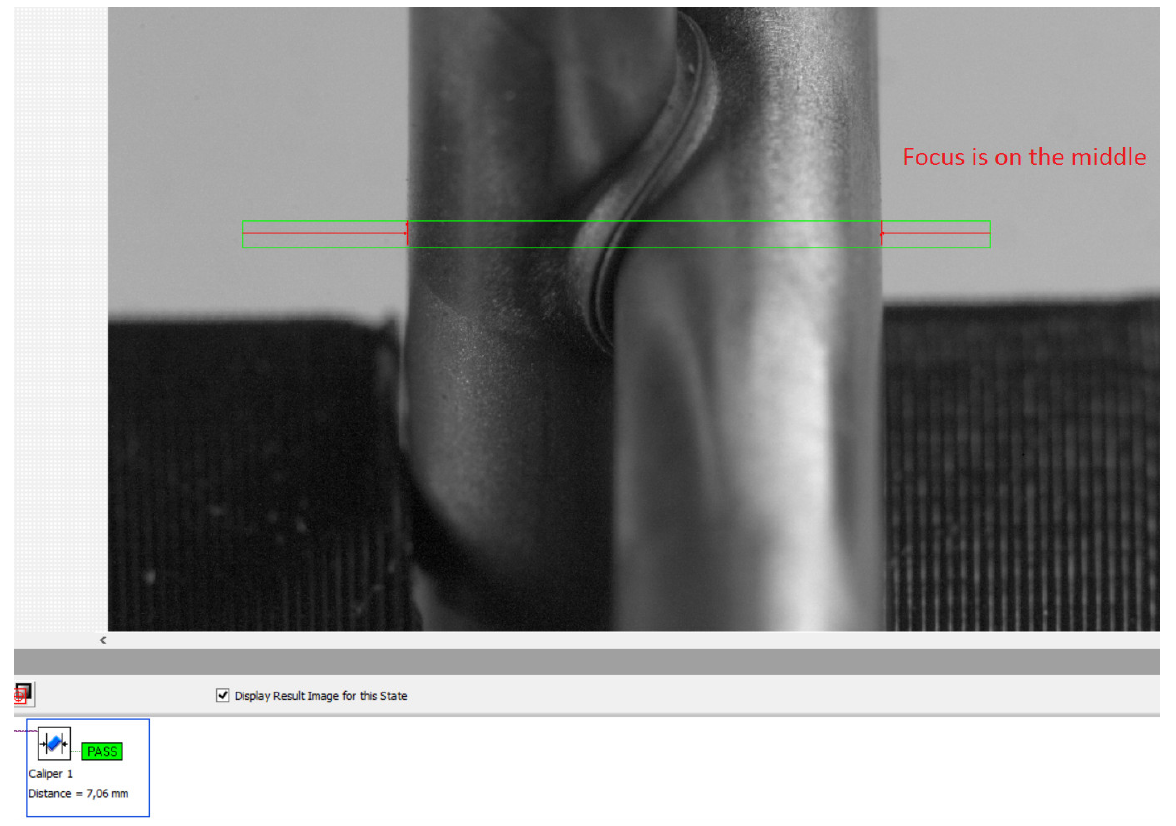
Figure 9. Measuring dimension in NiVison program with a focus in the middle of wire crossing. All other results are made for the cases where the focus is on the middle of the crossing. Figure 10 shows a comparison of measurement results obtained by RMS and conventional micrometer for 81 objects. Mean value of RMS measurement results is 7.019 mm while for micrometer measuring that value is 7.003 mm. This shows that the error of RMS is less than one pixel size. The standard deviation of results obtained by RMS is 0.054 mm, while for the case of micrometer measuring it is 0.046 mm. This shows that measuring results using RMS can be considered as valid as results are within set criteria of acceptability.